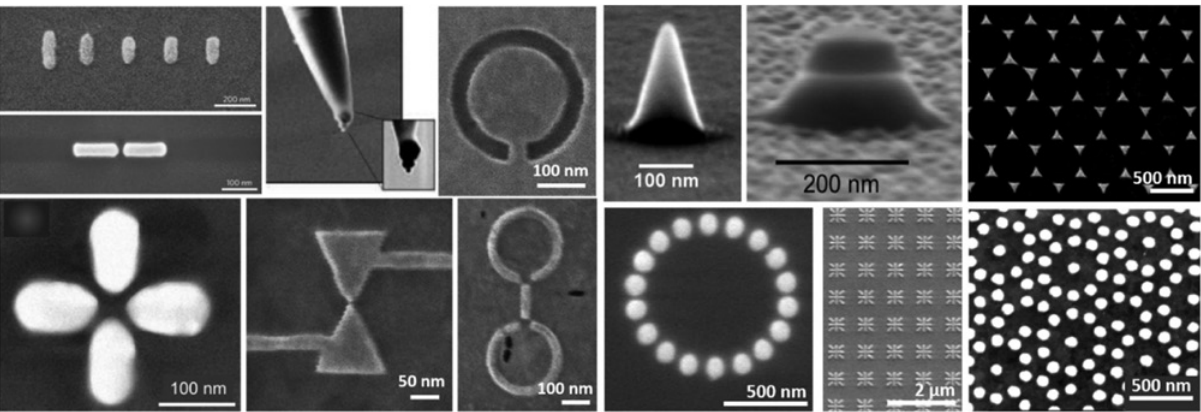
Figure 2: Clockwise from top left: Yagi-Uda antenna from Ref. [22] reprinted with permission from AAAS, a glass fiber tip with attached noble metal nanoparticles reprinted from Ref. [51], negative splitring, gold cone on substrate [52], vertical dimer gold-Al nanotriangles prepared by nanosphere lithography [52], gold nanodiscs in quasicrystalline order [52], star-shaped gold nanoantennas [52], corral shape made from gold nanoparticles [52], two coupled splitrings, connected bowtie antenna, cross antenna [26], and coupled λ /2